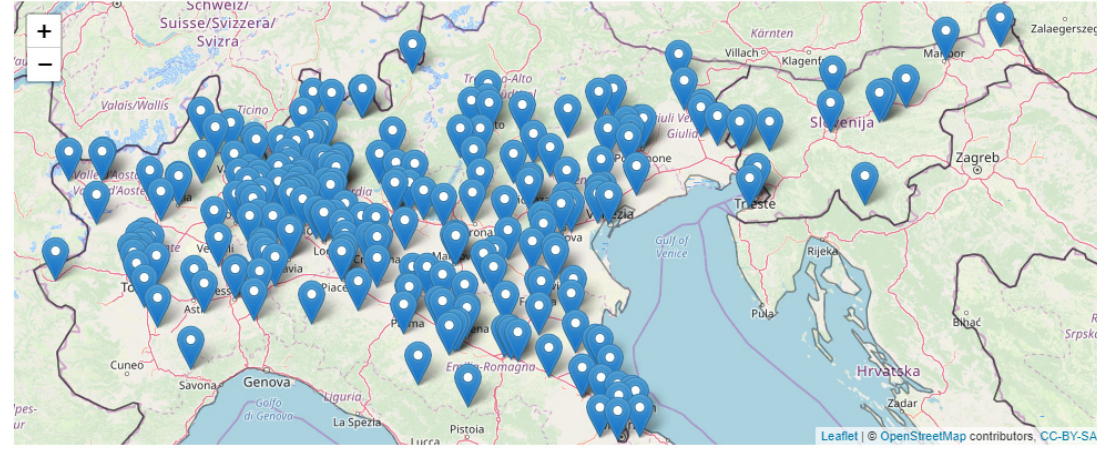
Figure 7. Station network for data sharing.